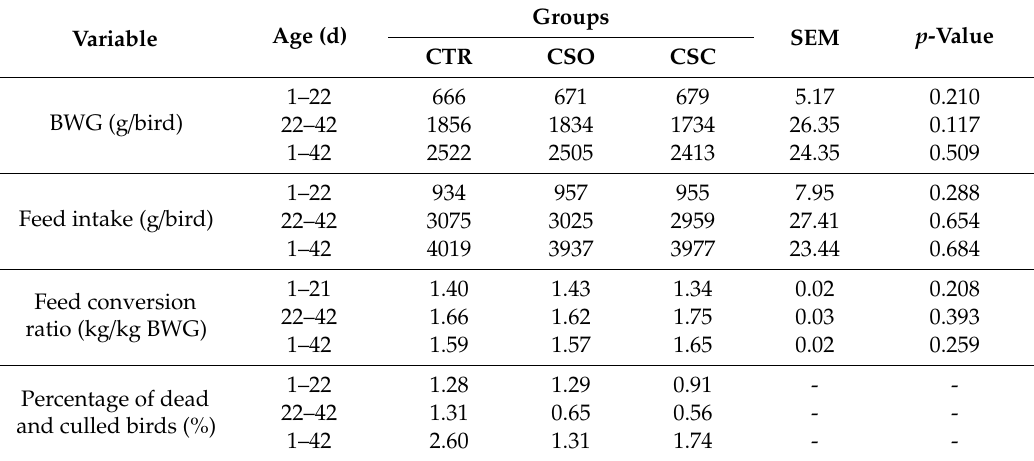
Table 4. Production parameters of broiler chickens. Abbreviations: BWG, body weight gain.